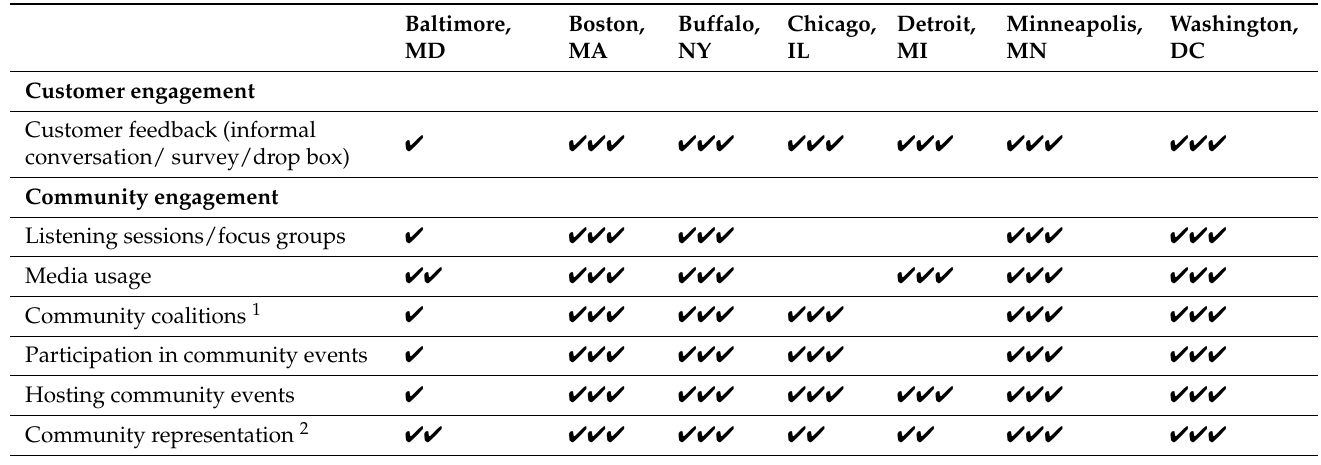
Table 1. Customer and community engagement activities and level of implementation across